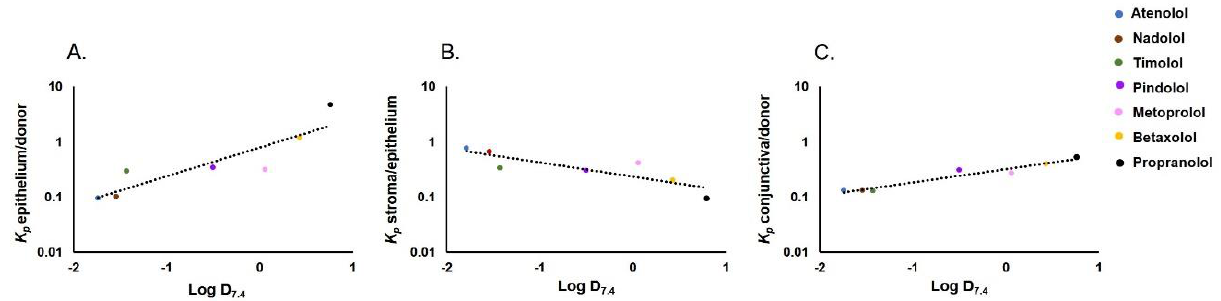
Figure 4. Relationship between Log D 7.4 and K p values. ( A ) epithelium/donor, (R 2 = 0.786), ( B ) stroma/epithelium (R 2 = 0.732), ( C ) conjunctiva/donor (R 2 = 0.940).